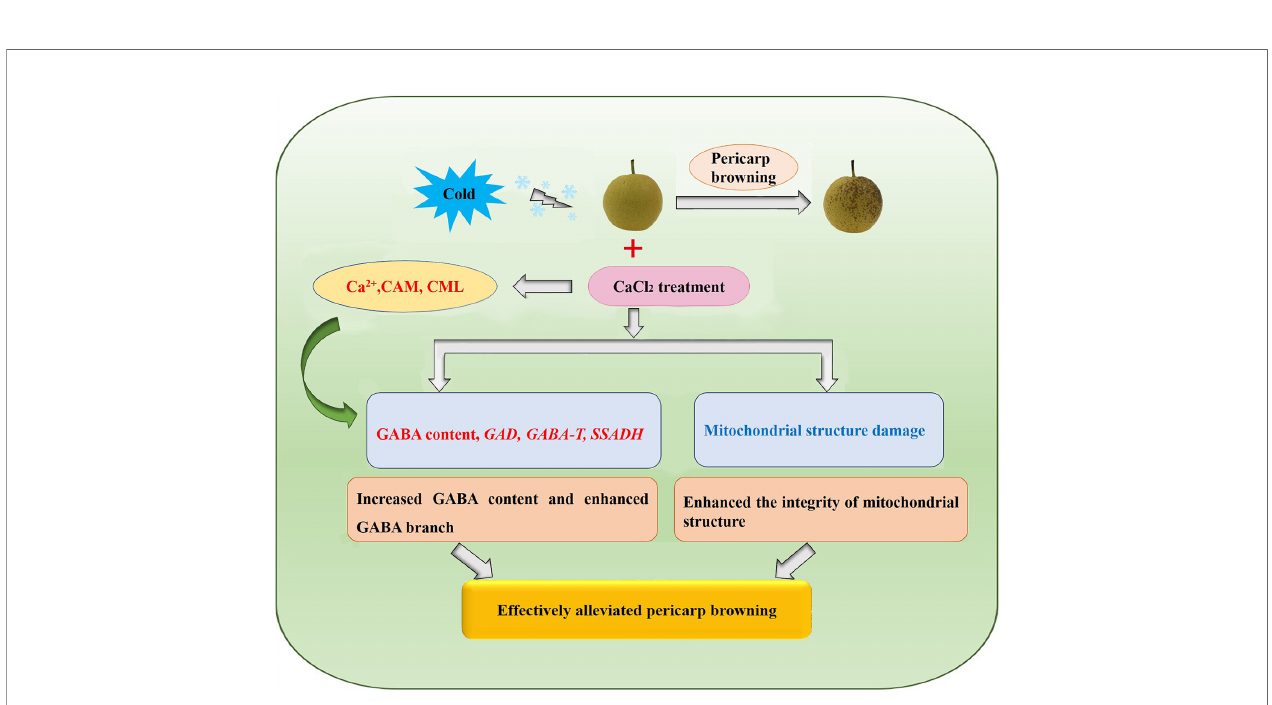
FIGURE 6 | Proposed regulation module of pericarp browning alleviation through CACl 2 treatment. CaCl 2 treatment increased the content of Ca 2+ and calmodium content in ‘ Nanguo ’ pear, thereby promoting GABA synthesis, increasing the activity and relative expression of GAD, GABA-T and SSADH in GABA shunt anabolism, and reducing the damage of mitochondrial structure caused by long-term cold storage, and fi nally ameliorating the pericarp browning. Red words represent promotion, whereas the blue ones represent inhibition. Details are described in the